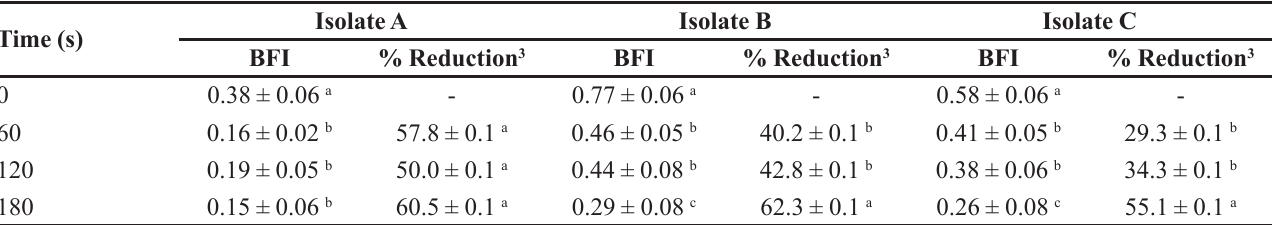
TABLE I - Biofilm-forming index (BFI) and respective percentage reduction of biofilm-producing L. monocytogenes isolates (A-C 1 ) on polystyrene microplates, after treatments with peracetic acid (0.5 %) at different contact times 2